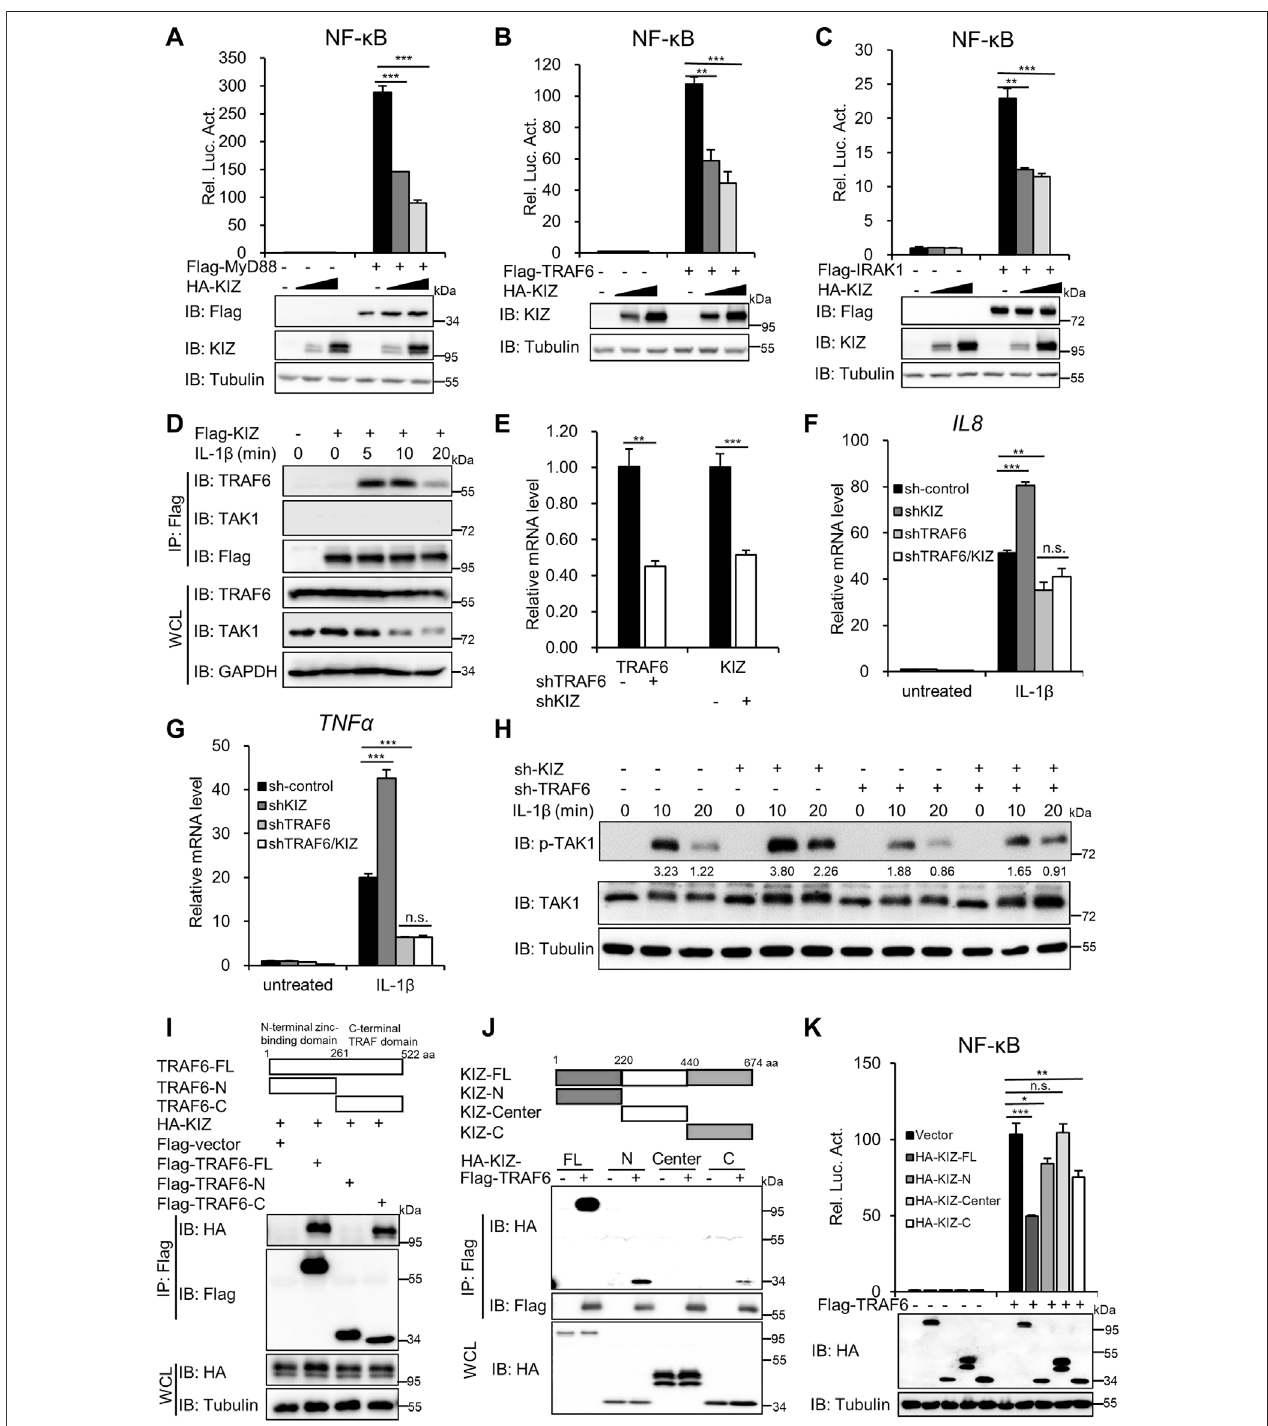
FIGURE 4 | KIZ regulates IL-1 β -induced NF- ĸ B activation by targeting TRAF6. (A – C) . HEK293T cells were transfected with increasing doses of KIZ plasmids or an emptyvectortogetherwithanNF- κ B-LucreporterandplasmidsthatexpressedFlag-MyD88 (A) ,Flag-TRAF6 (B) ,orFlag-IRAK1 (C) .Twenty-fourhoursaftertransfection,the cells were lysed for luciferase reporter assays (upper panel) and immunoblotting (lower panels). (D) HEK293 C6 cells were transfected with a Flag-tagged KIZ expression plasmid. After 24 h, the cells were untreated or treated with IL-1 β (5 ng/ml) for the indicated times, lysed for IP with anti-Flag beads, and then analyzed by immunoblotting. (E – H) HeLacellswereinfectedwithashRNAlentivirusthattargeted KIZ , TRAF6 ,both,ortheemptyvectorfor48 h.Thecellswereuntreatedortreatedwith IL-1 β (20 ng/ml)for3 handthenanalyzedbyqPCRtomeasurethemRNAlevelsof KIZ , TRAF6 (E) , IL8 (F) ,and TNF α (G) ortreatedfortheindicatedtimesandthenanalyzed